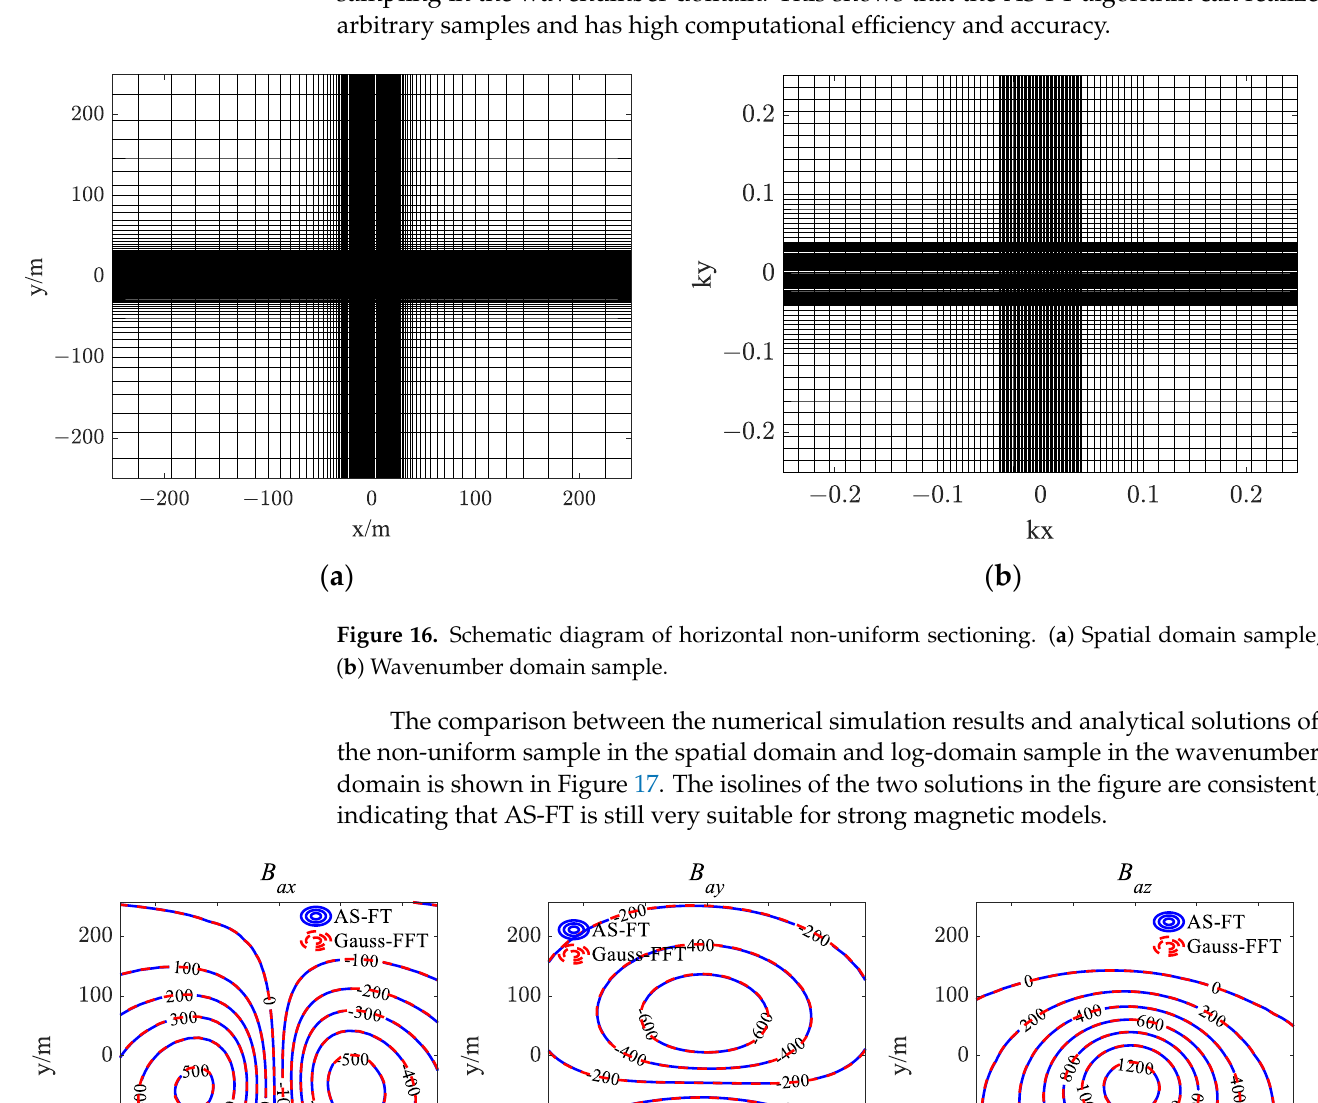
Figure 17. Comparison between numerical solutions and analytical solutions of strong magnetic sphere.